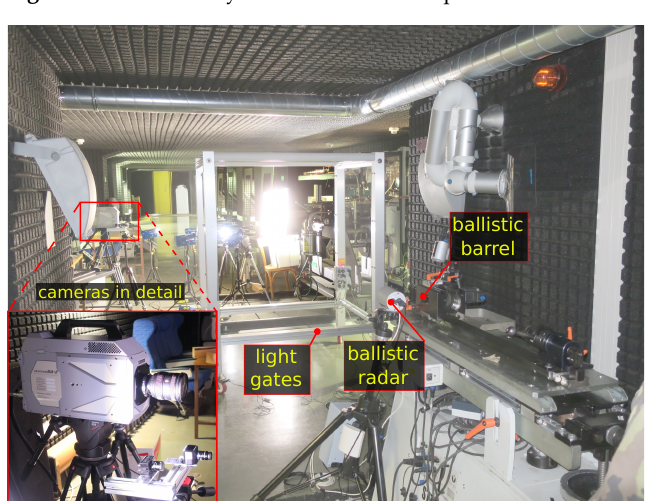
Figure 2. Schematic layout of the ballistic experiment.